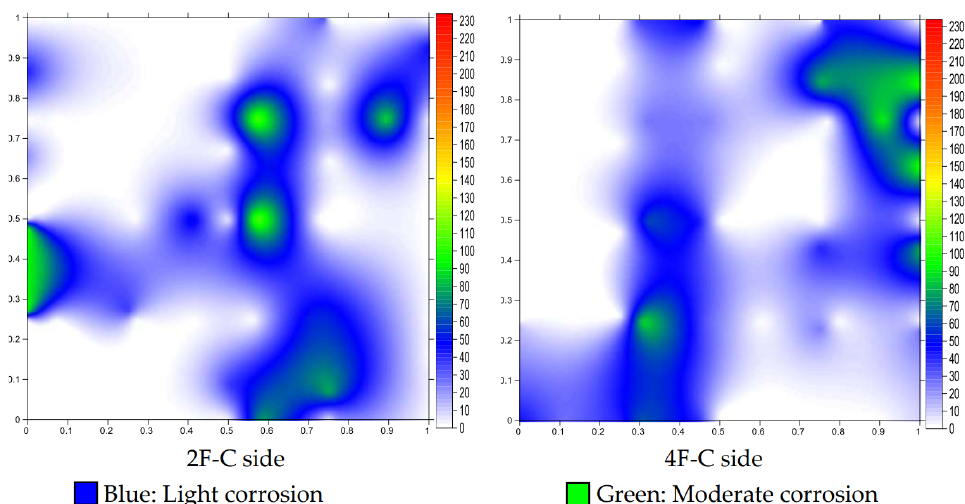
Figure 22. Steel Bar Corrosion in Concrete Column.